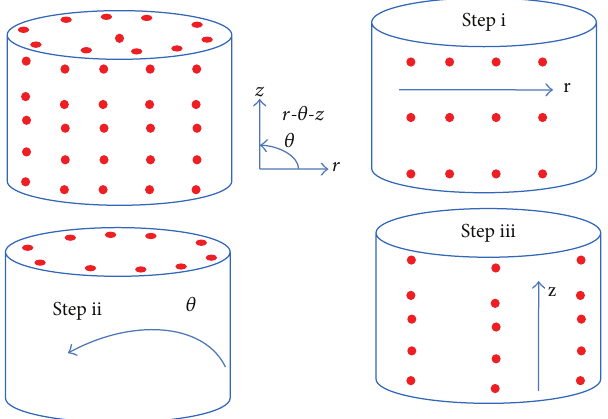
Figure 2: ADI steps to solve the conduction equation. possible six combinations, like 𝑟 - 𝜃 - 𝑧 , 𝑟 - 𝑧 - 𝜃 , 𝜃 - 𝑟 - 𝑧 , 𝜃 - 𝑧 - 𝑟 , 𝑧 - 𝑟 - 𝜃 , and 𝑧 - 𝜃 - 𝑟 , have been used to solve the heat diffusion equation and compared